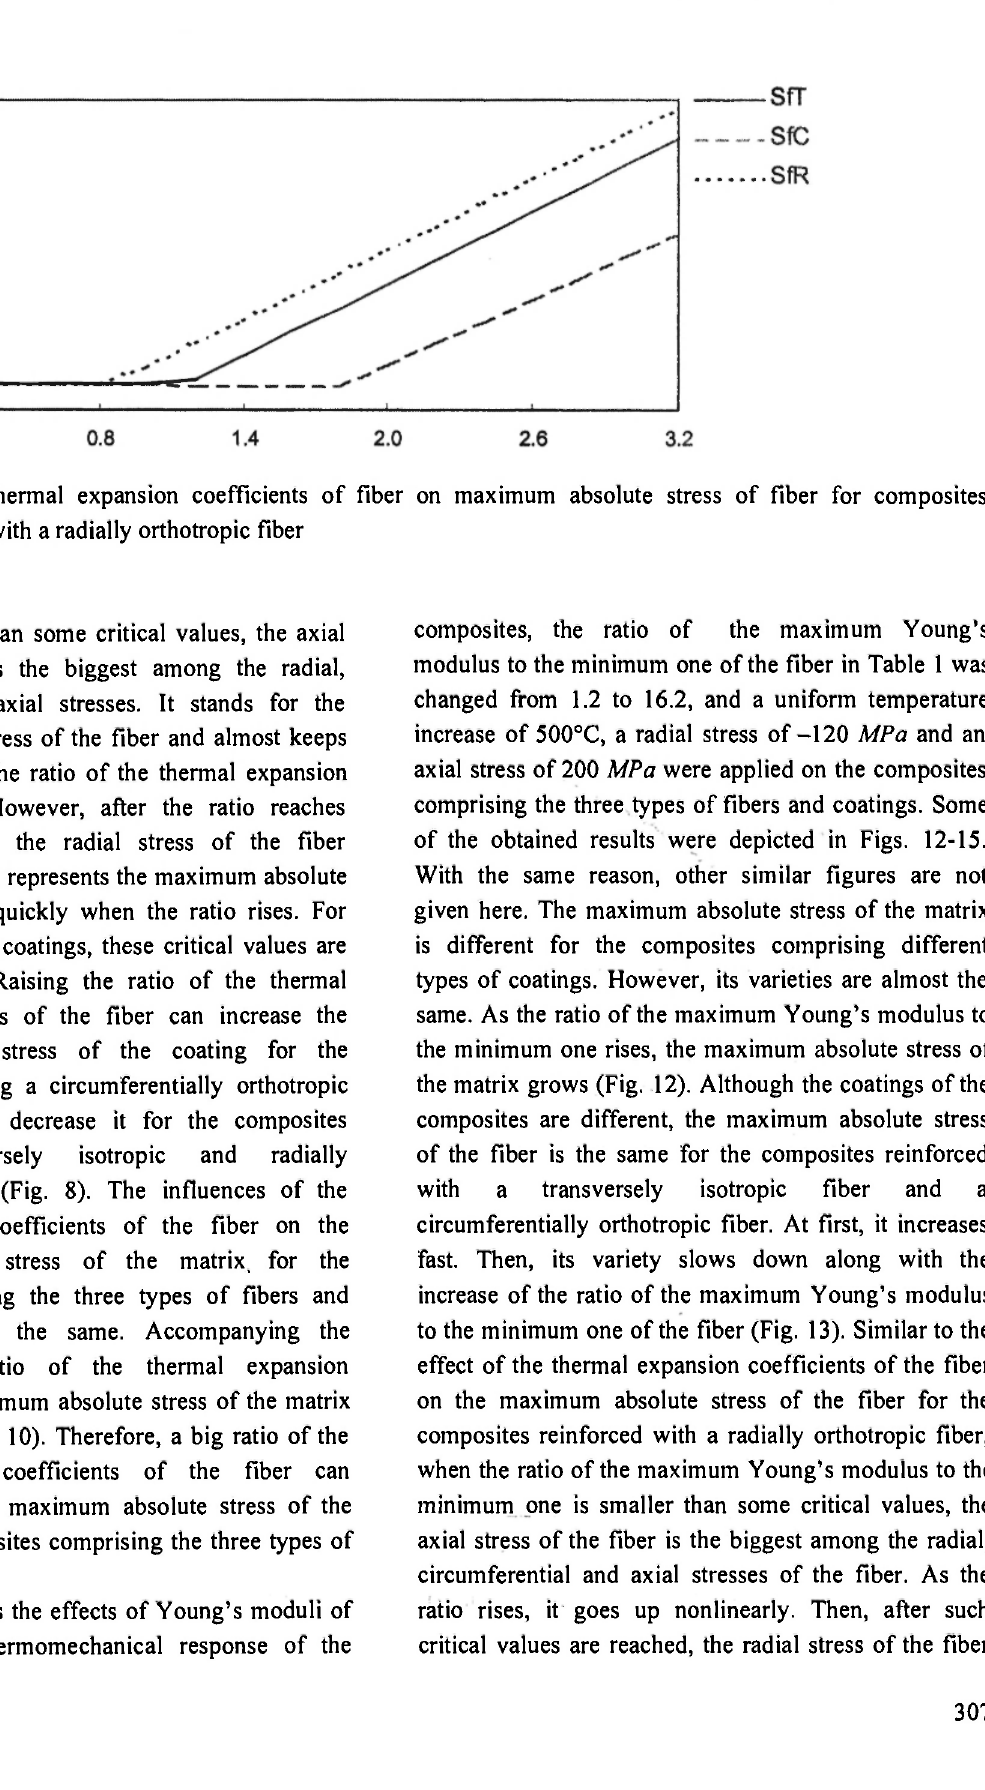
Effect of thermal expansion coefficients of fiber on maximum absolute stress of fiber for composites reinforced with a radially orthotropic fiber